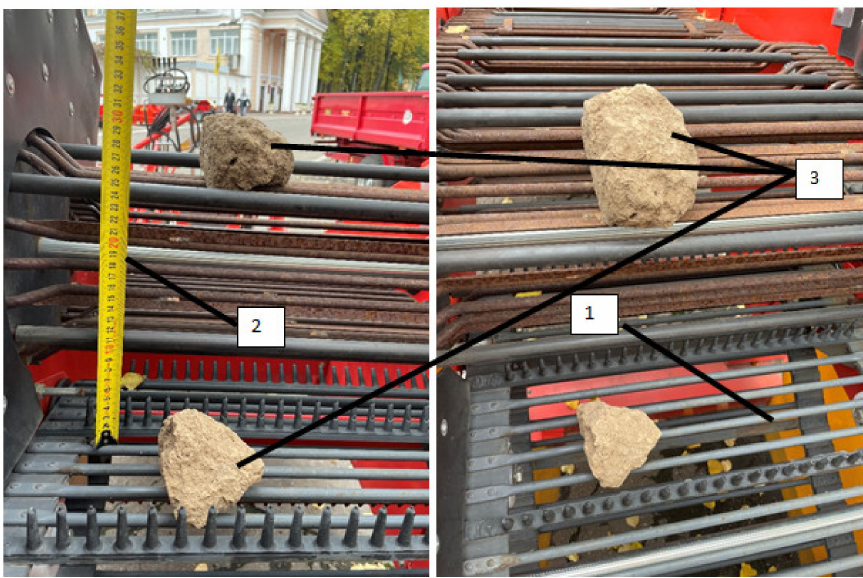
Figure 9. General view of the destruction of soil clods on the bars of the separating surface: 1—the canvas of the rod elevator; 2—reference scale; 3—soil